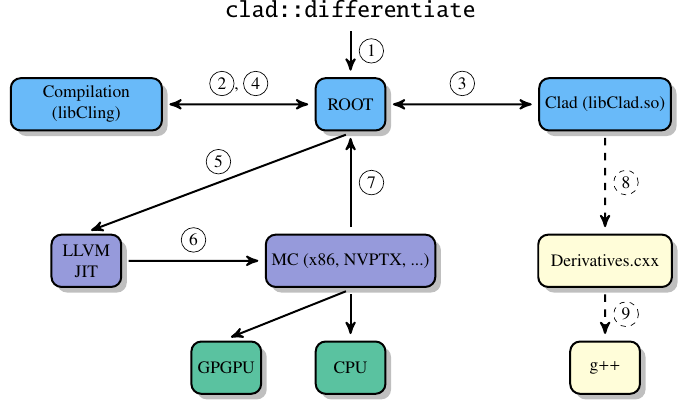
Figure 1: Information flow of Clad in